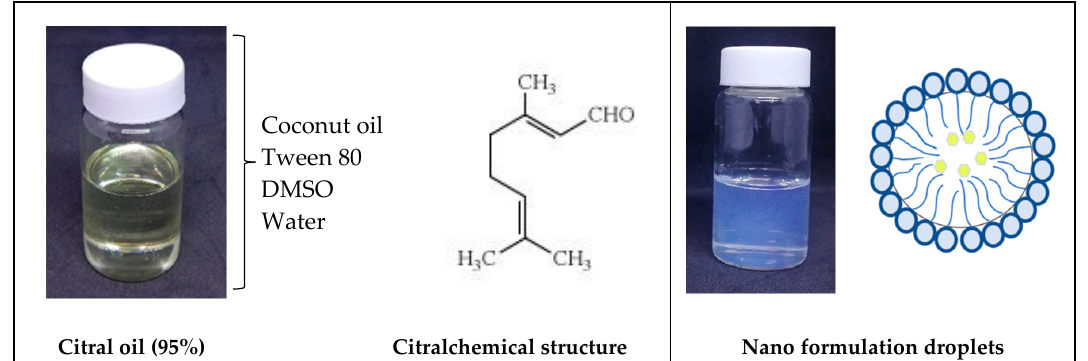
Figure 6. Illustration showing the preparation of Citral-loaded self nano-emulsifying drug delivery system (CIT-SNEDDS) after 72 h gentle agitation from Citral oil (95%). Chemical structure;